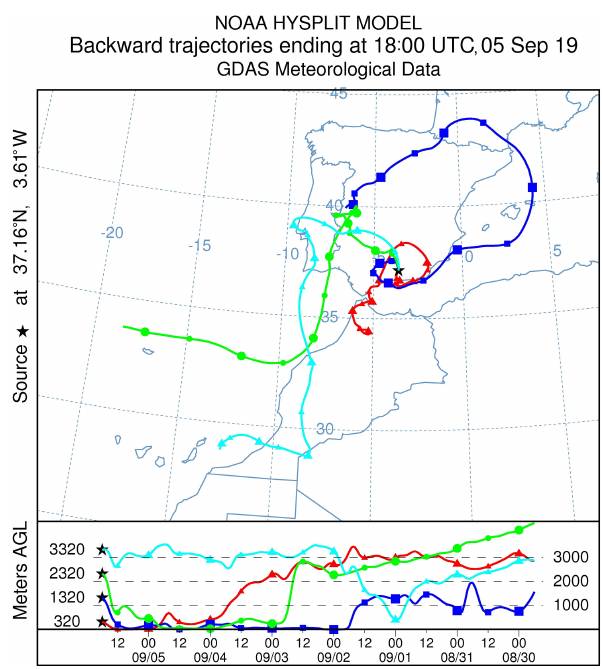
Figure 4. HYSPLIT model back trajectories for the air masses over Granada between 0.3 and 3.3kma.g.l. (equivalent to approximately 1 and 4kma.s.l., respectively) at 18:00UTC on 5 September 2019.